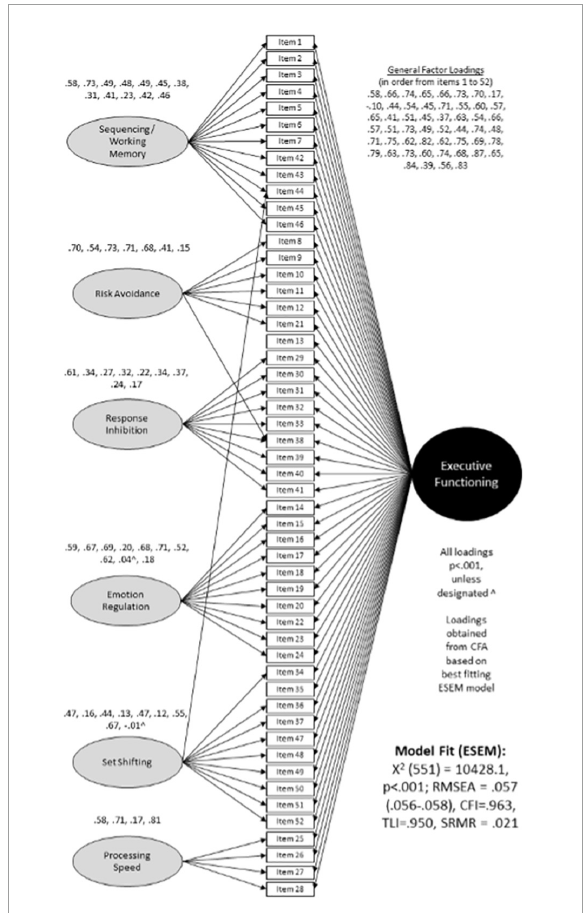
FIGURE1 Factor structure of the Executive Functioning Scale